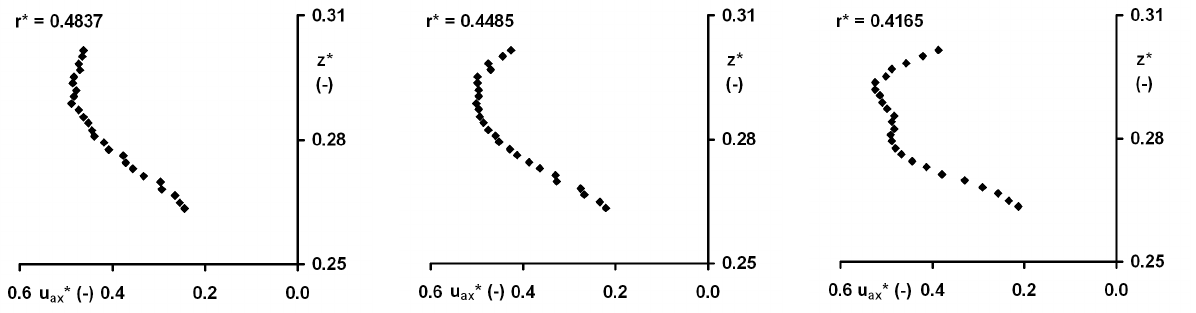
= f ( z * ) in the impeller discharge stream. ax